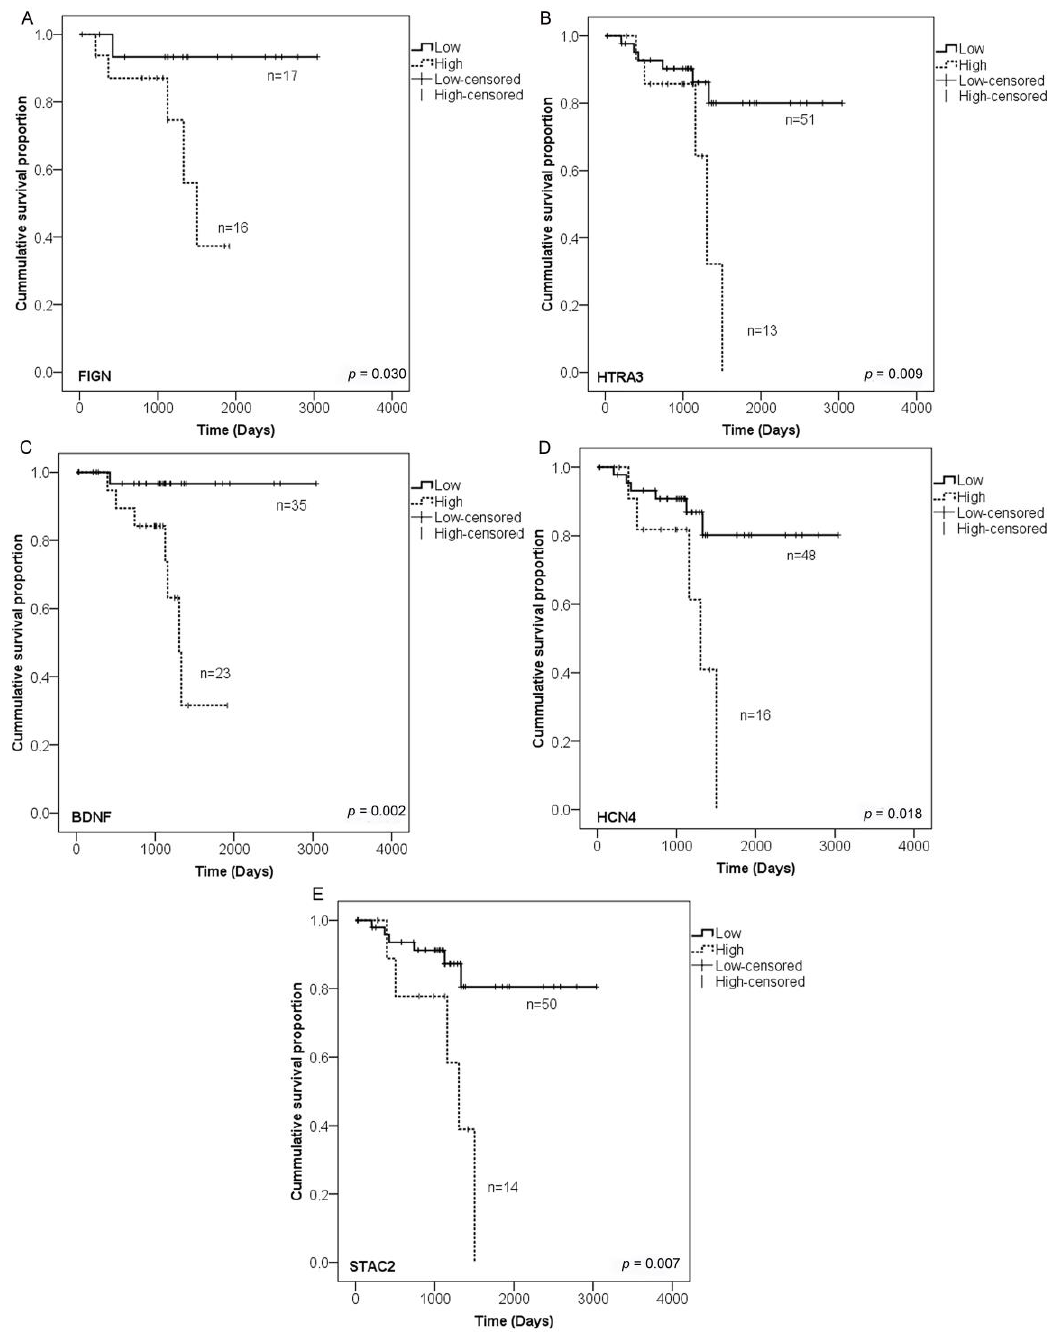
Figure 4. Kaplan–Meier survival curves for patients with colorectal cancer from The Cancer Genome Atlas (TCGA) cohort. The solid lines indicate patients with low levels of CGI methylation and the dotted lines indicate patients with hypermethylation of CGIs overlapping candidate genes. ( A ) FIGN ( p = 0.030); ( B ) HTRA3 ( p = 0.009); ( C ) BDNF ( p = 0.002); ( D ) HCN4 ( p = 0.016) and ( E ) STAC2 ( p = 0.007). Stratified log-rank